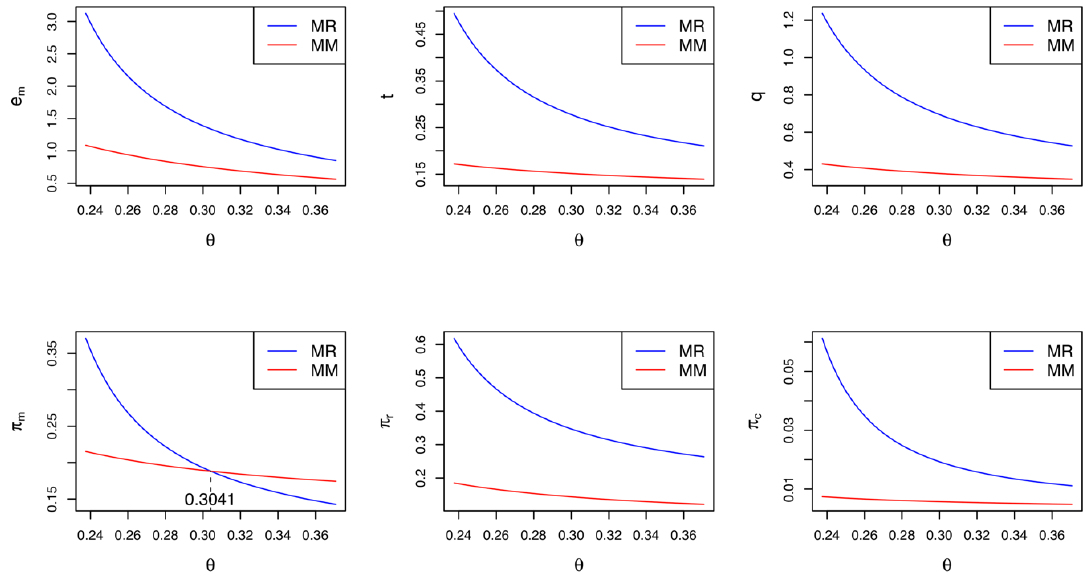
Figure 2. Comparisons between Model MM and Model MR.